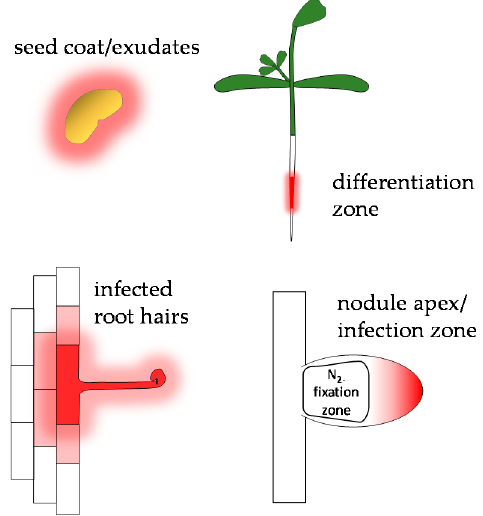
Figure 4. The production and secretion of flavonoids at different stages of growth and development in Medicago spp. ( Top left ) Luteolin and other flavonoids are produced in seed coat and are released in the exudate upon imbibition and may play a role in chemoattraction of rhizobia [17,44,45]. ( Top right ) Flavonoids are produced in the root hair elongation zone and some are secreted into the rhizosphere [31,48,106]. ( Bottom left ) ChOMT genes are expressed in rhizobially infected root hairs, suggesting that the nod gene-inducer methoxychalcone is produced locally [50,51]. ( Bottom right ) ChOMT genes are also expressed in the nodule apex/infection zone where infection threads are present, but not in the nitrogen fixation zone [49,50].